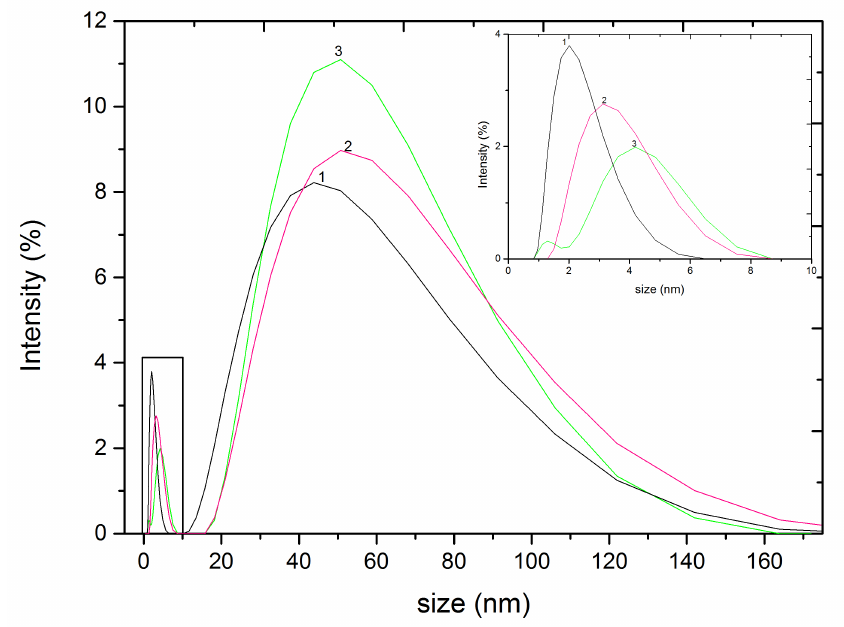
Figure 6. Dynamic Light Scattering particle size distribution (by intensity) of silver NPs synthesized with extracts: 1—Silver seeds (SNP); 2—White cedar; 3—White thyme. Inset shows the peak distribution corresponding to the NPs with sizes below 8